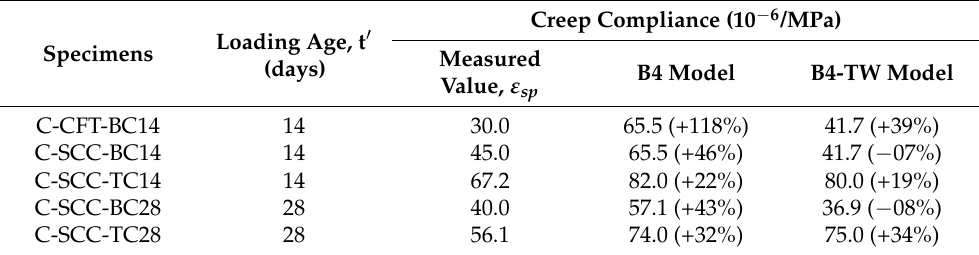
Table 10. Comparison of measured creep compliance and predicted results at 375 days after